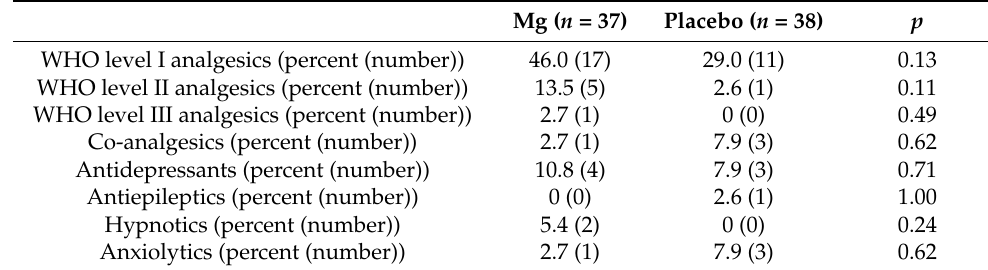
Table 4. Drug initiation after the beginning of the study ( n =